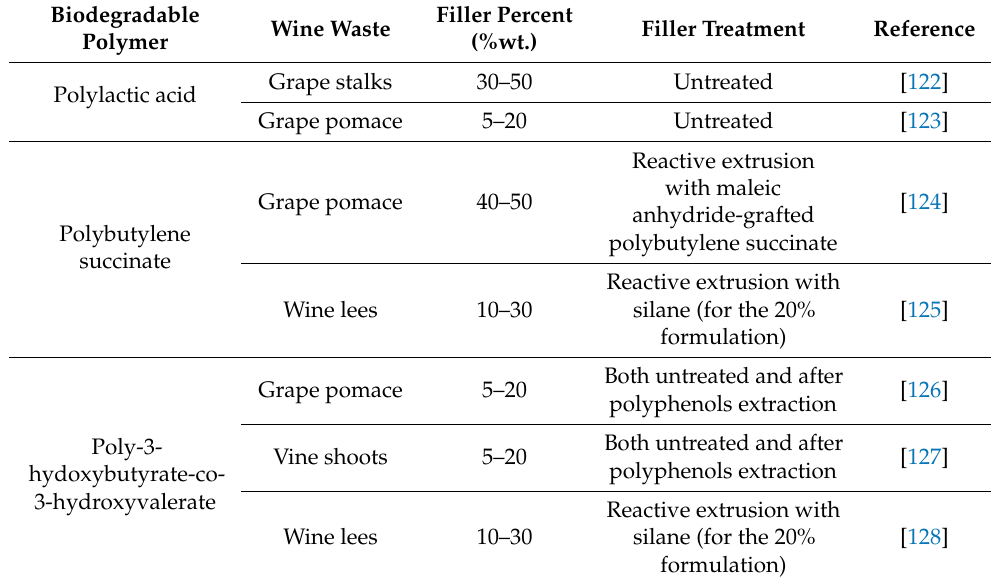
Table 7. Biocomposites obtained from biopolymers and wine by-products as reinforcing